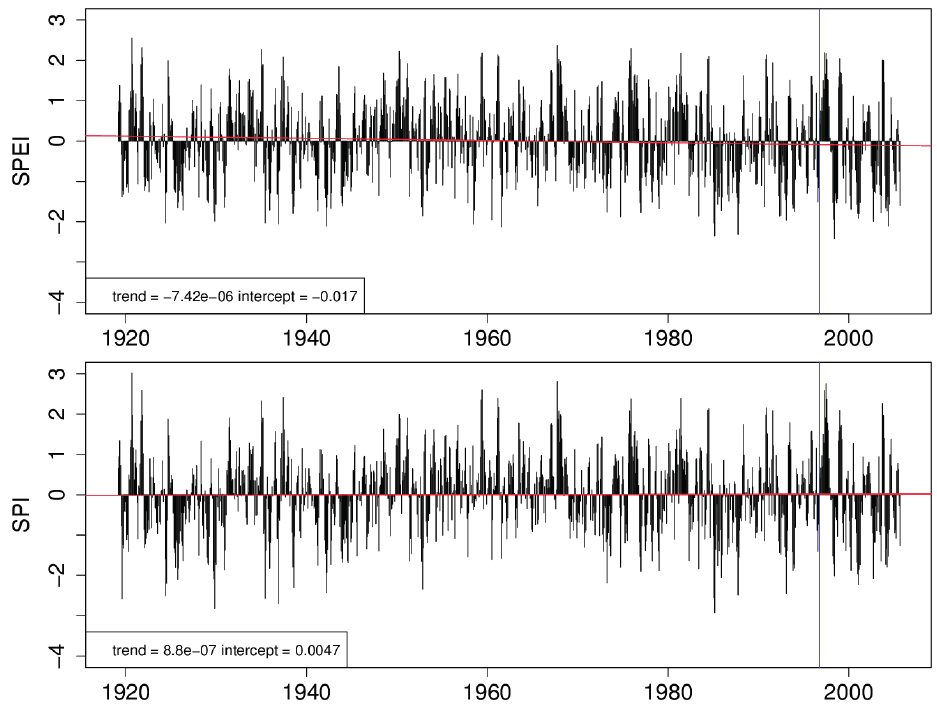
Figure 11. The Standardized Precipitation Evaporation Index (SPEI) and the Standardized Precipitation Index (SPI) over 1919 to 2005 implemented with the three-month